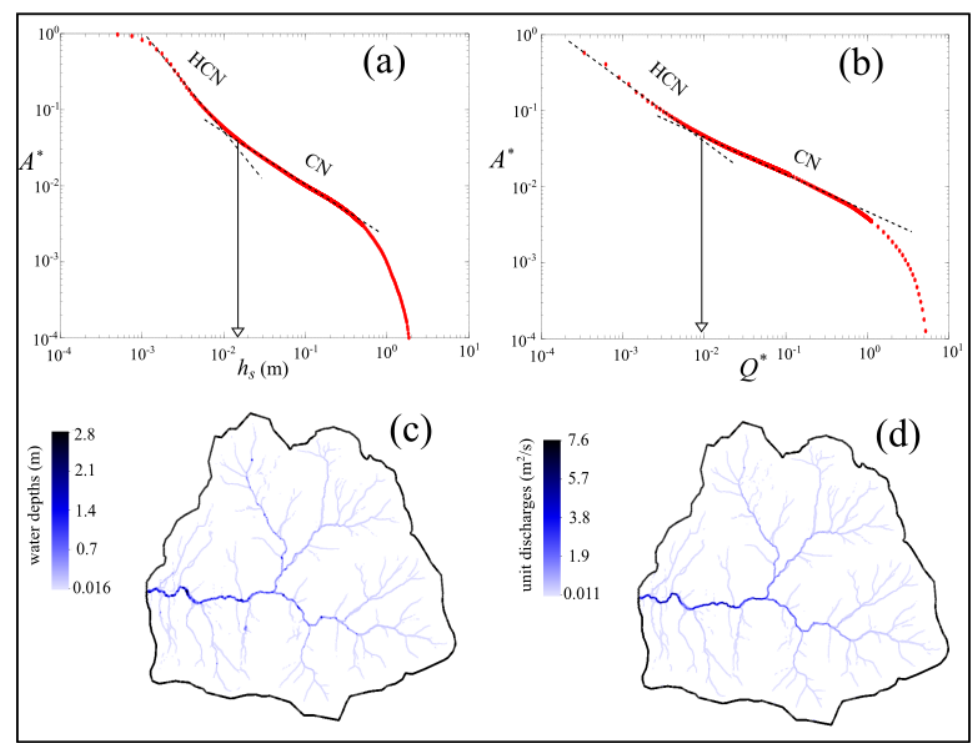
Figure 1. Typical profiles characterizing the A *- h s and A *- Q * curve ( a , b ) and the associated drainage patterns associated to the values of h s and Q * estimated in the part of the curves, in which the break of derivative occur ( c , d ), (from Costabile and Costanzo, 2021, modified).